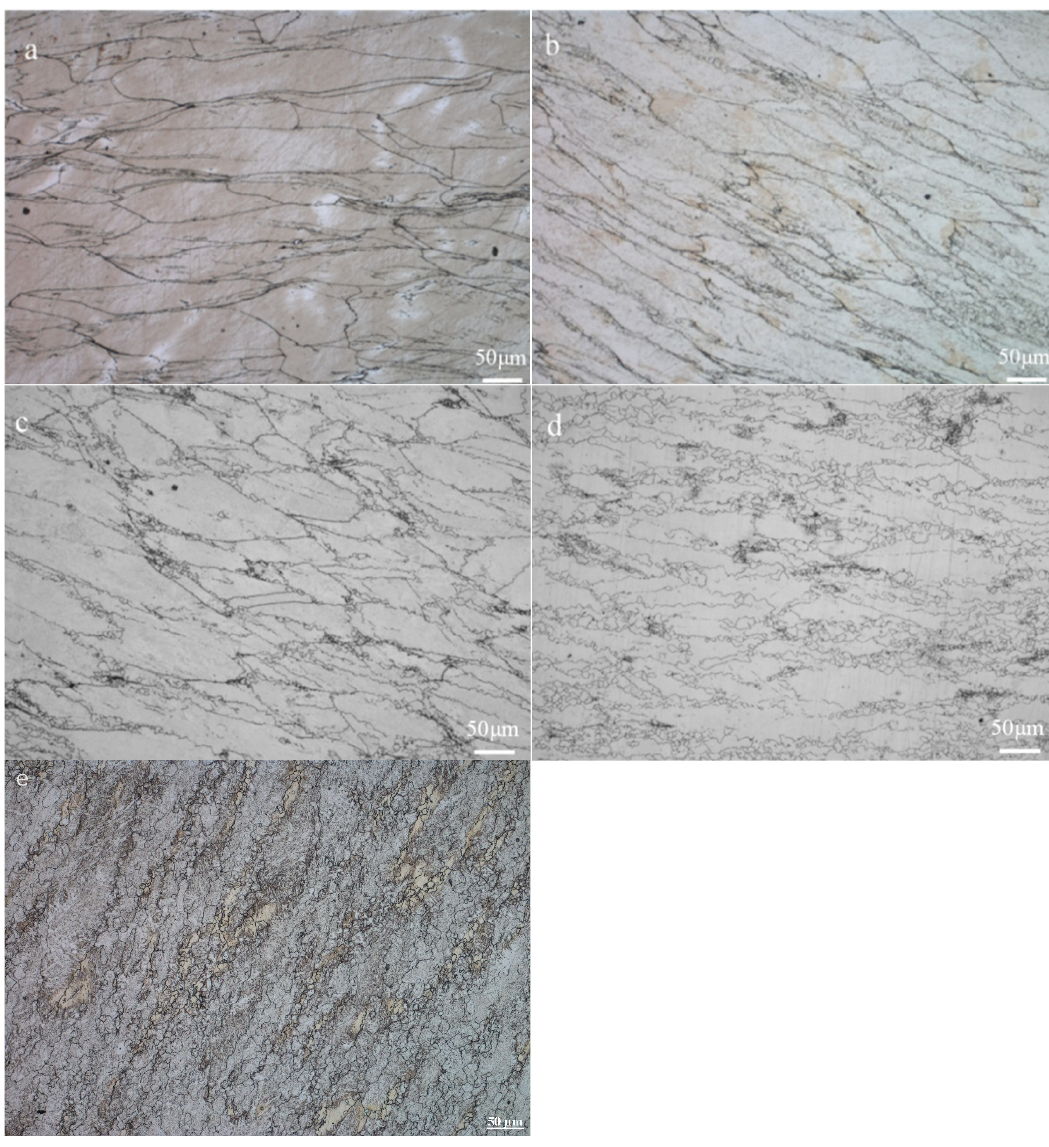
Figure 9. Microstructure at a deformation rate of 0.1 s − 1 and at different deformation temperatures: ( a ) 900 °C, ( b ) 950 °C, ( c ) 1000 °C, ( d ) 1050 °C, and ( e ) 1100 °C. Average grain lengths: ( a ) 310 μ m, ( b ) 230 μ m, ( c ) 150 μ m, ( d ) 110 μ m, and ( e ) 70 μ m.